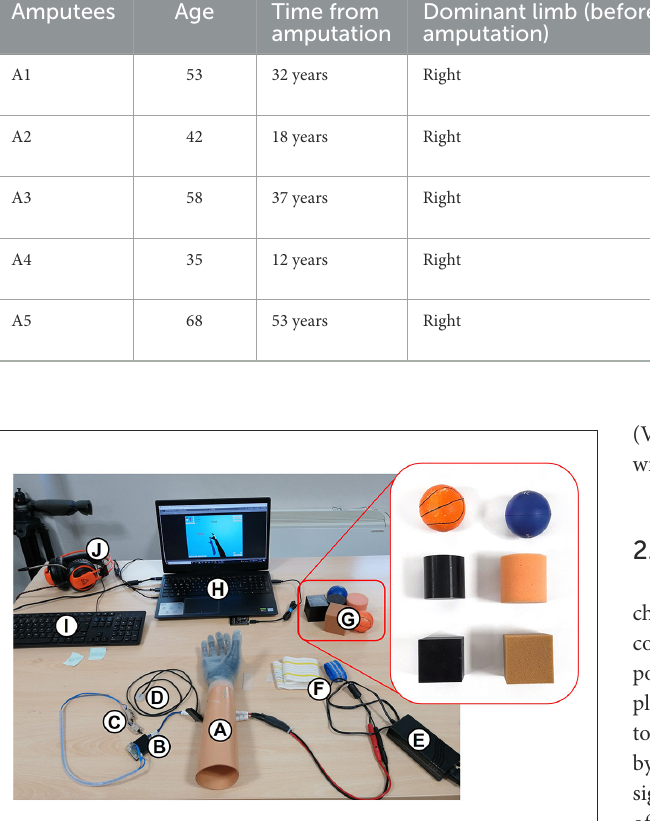
FIGURE1 Experimental setup used to perform the task on healthy subjects and amputees. It consists of: (A) socket with the Hannes prosthesis; (B) the EMGM to control the Hannes hand, recognize the grasped object, and provide feedback; (C) EMG sensors; (D) vibromotors; (E) power supply; (F) elastic band to attach the EMGs and vibromotors to the forearm; (G) the objects used to perform the task; (H) laptop with the virtual reality; (I) keyboard to choose between rigid, soft, or void; (J) headphones to isolate the participants during the